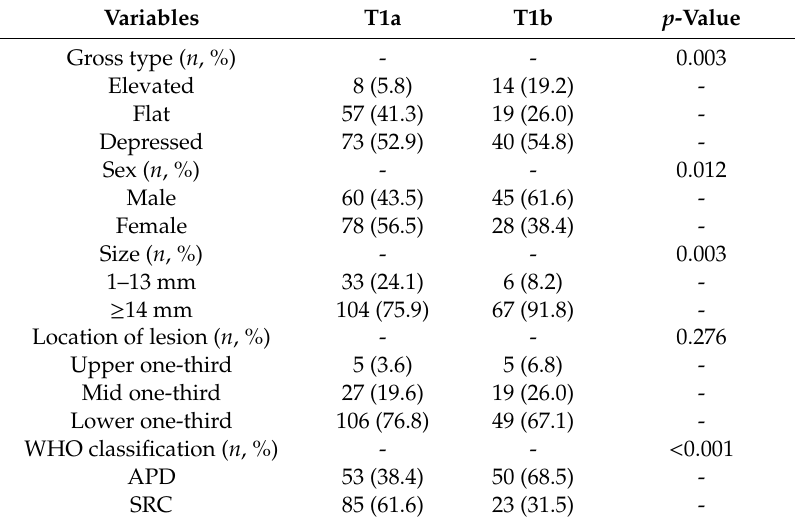
Table 5. Associated factors according to T-staging in undi ff erentiated-type adenocarcinoma. Variables T1a